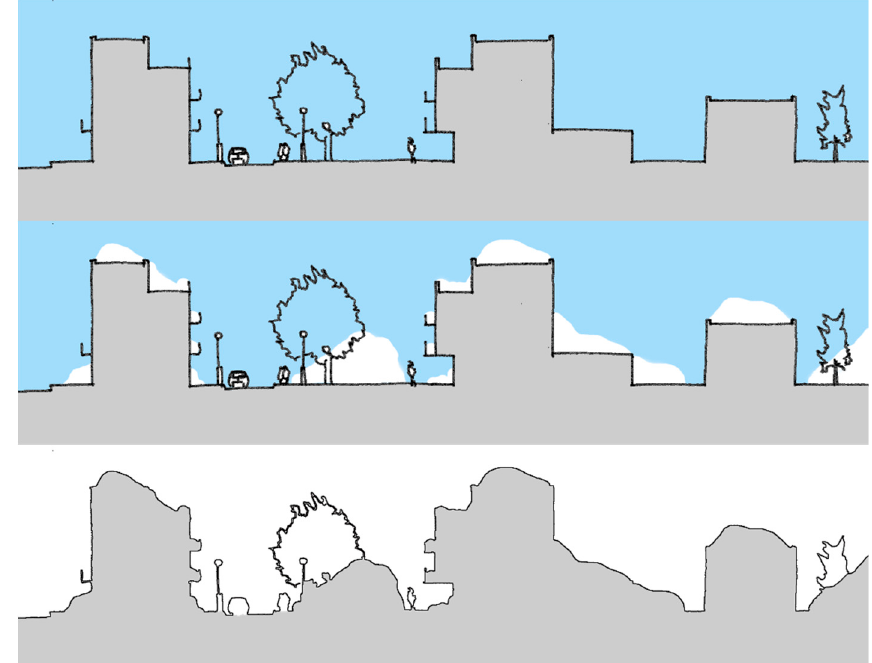
Figure 6. Illustration of how the winter season can re-order the space of the built environment. Top image: Section through the urban form of the street. Middle: Section of the street including winter season deposits. Bottom: The remaining space comprising the public realm in winter.